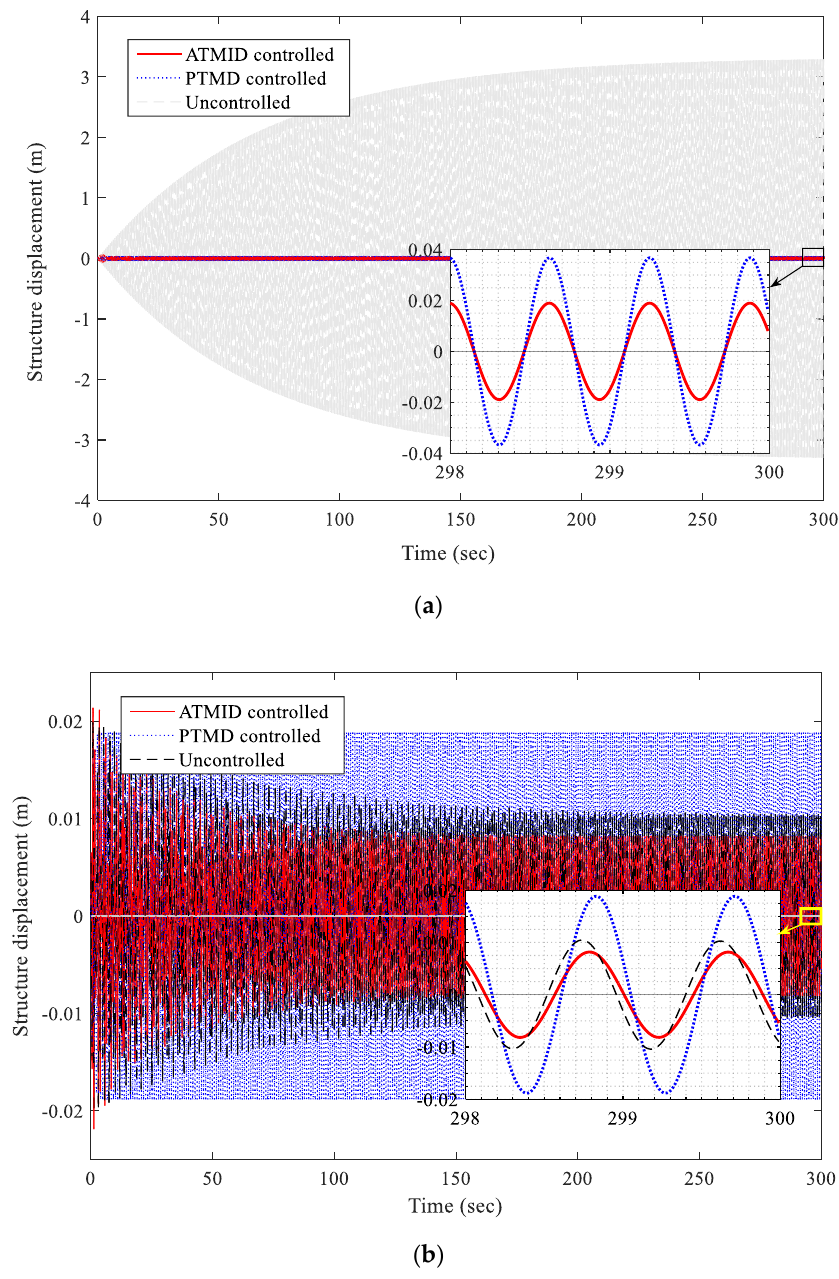
Figure 10. Structural displacement time-history at: ( a ) resonance frequency of 10 (rad/s), ( b ) fre- quency of 7.13 (rad/s).